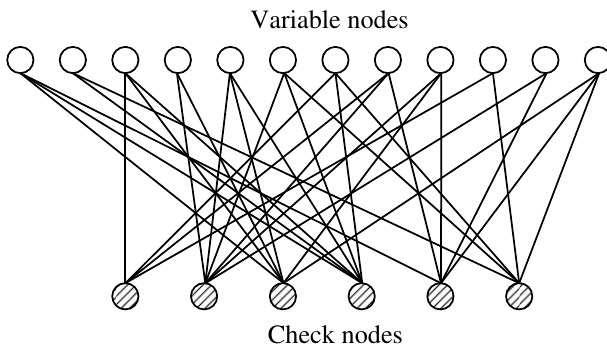
Figure 5. H matrix used in the